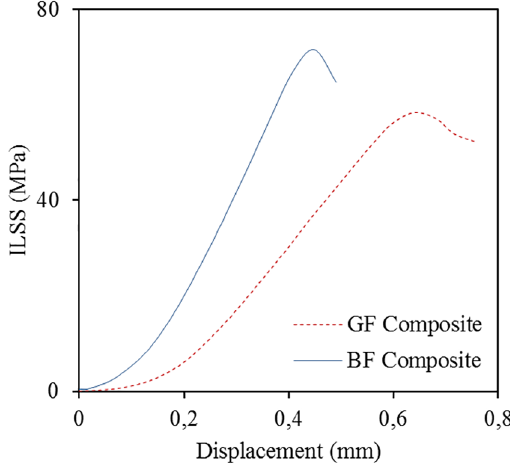
Figure 4. Typical load-displacement curves during ILSS test of BF and GF